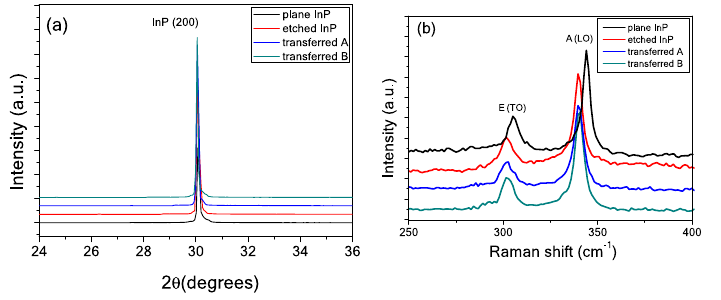
Figure 4. Four samples for ( a ) XRD patterns, ( b ) surface Raman